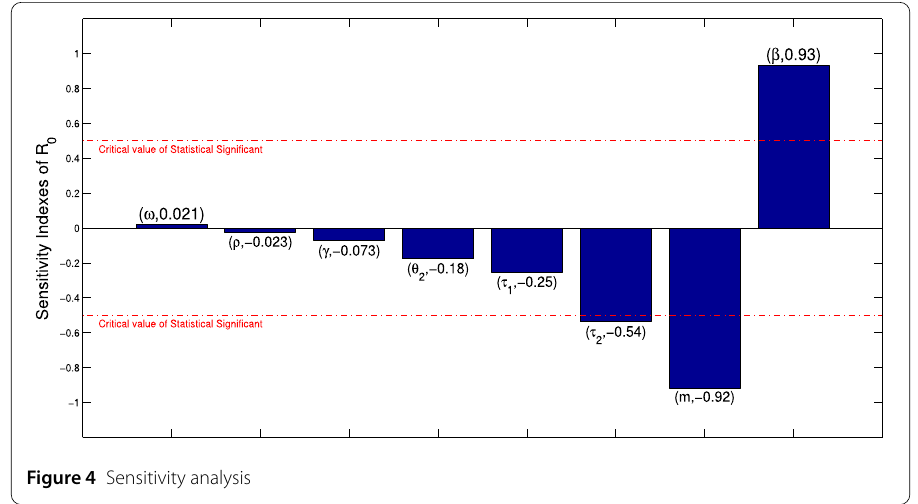
Figure 4 Sensitivity analysis